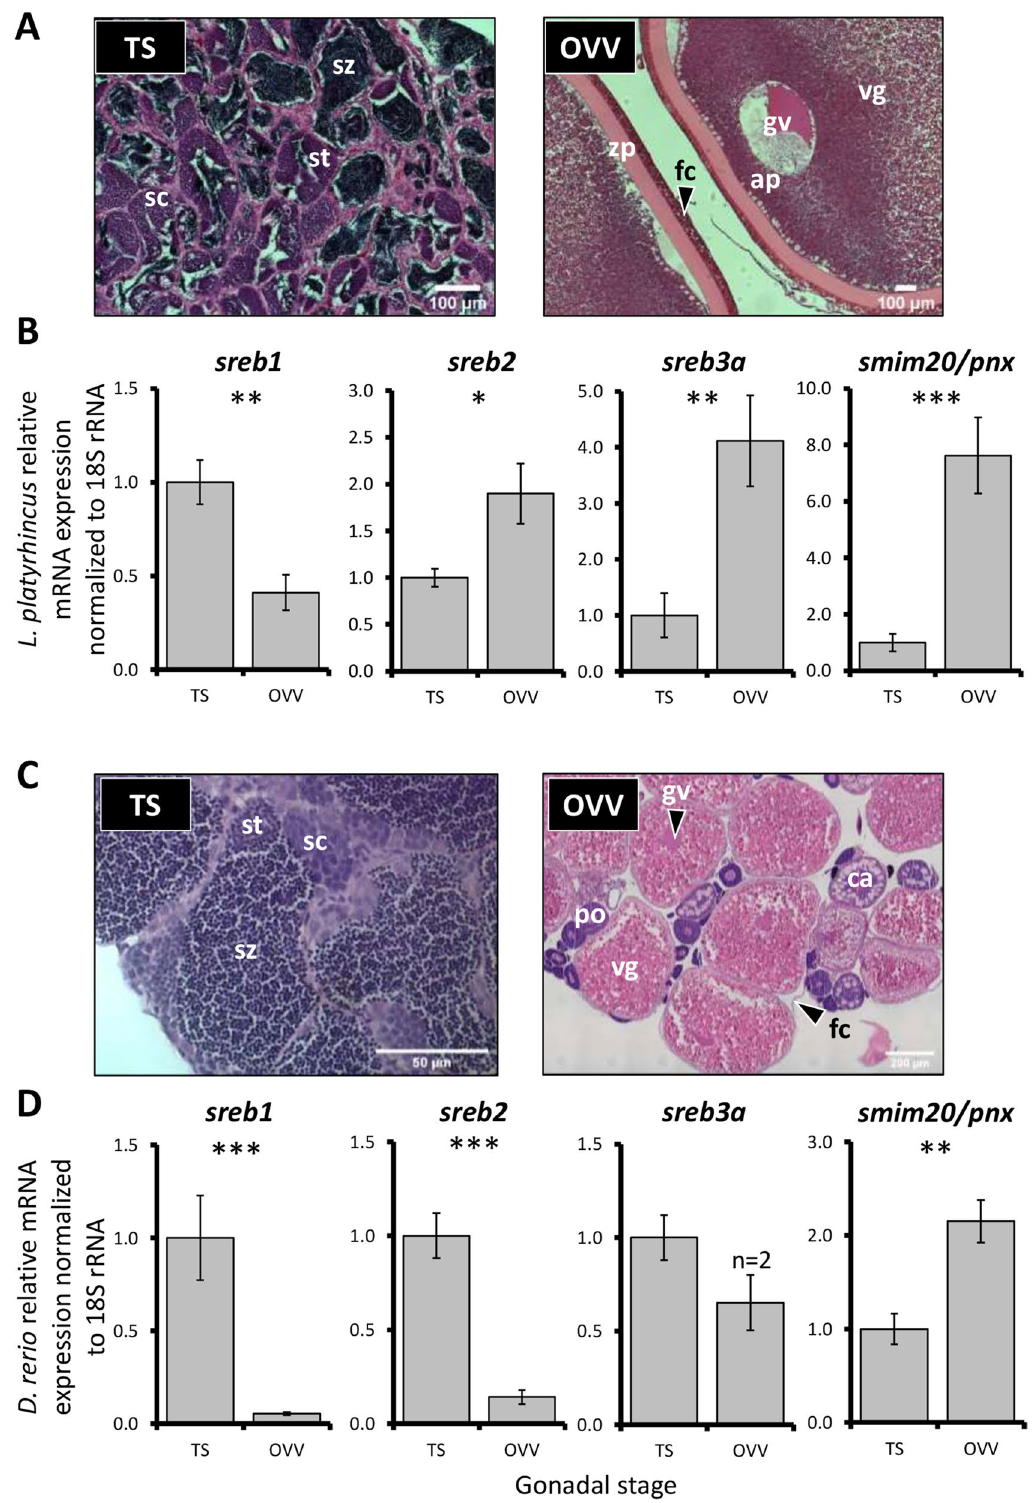
Figure 5. Florida gar ( Lepisosteus platyrhincus ) ( A ) representative gonadal histology and ( B ) relative mRNA expression of sreb genes and smim20/pnx , normalized to 18S rRNA. Similar zebrafish ( Danio rerio ) stages and relative mRNA expression are shown in C and D, respectively. The TS stage refers to testes with visible spermiation and abundant mature spermatozoa, while OVV refers to ovaries with mid-late stage vitellogenic oocytes. Each bar represents the mean ± standard error, and significant differences are indicated by *( p < 0.05), **( p < 0.01) or ***( p < 0.0001). ap = animal pole, ca = cortical alveoli (secondary) oocyte, fc = follicle cell wall, gv = germinal vesicle, po = primary oocyte, sc = spermatocytes, st = spermatids, sz = spermatozoa, and vg =